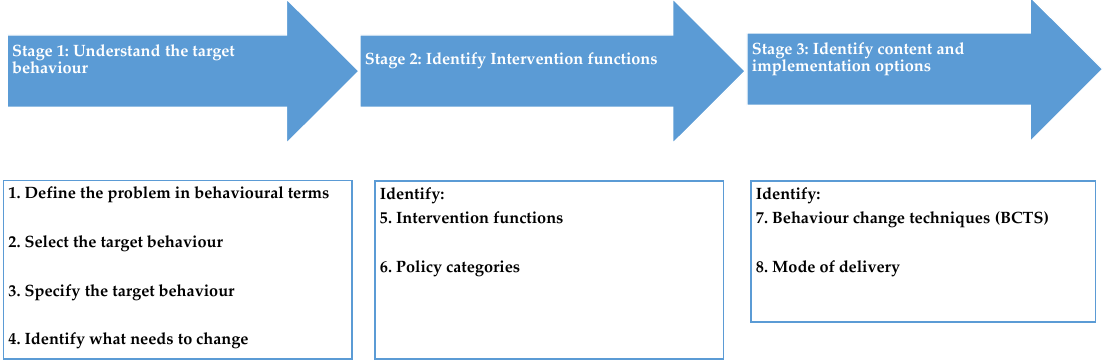
Figure 2. The BCW Intervention design process (Michie, Atkins & West, 2014 [22]).